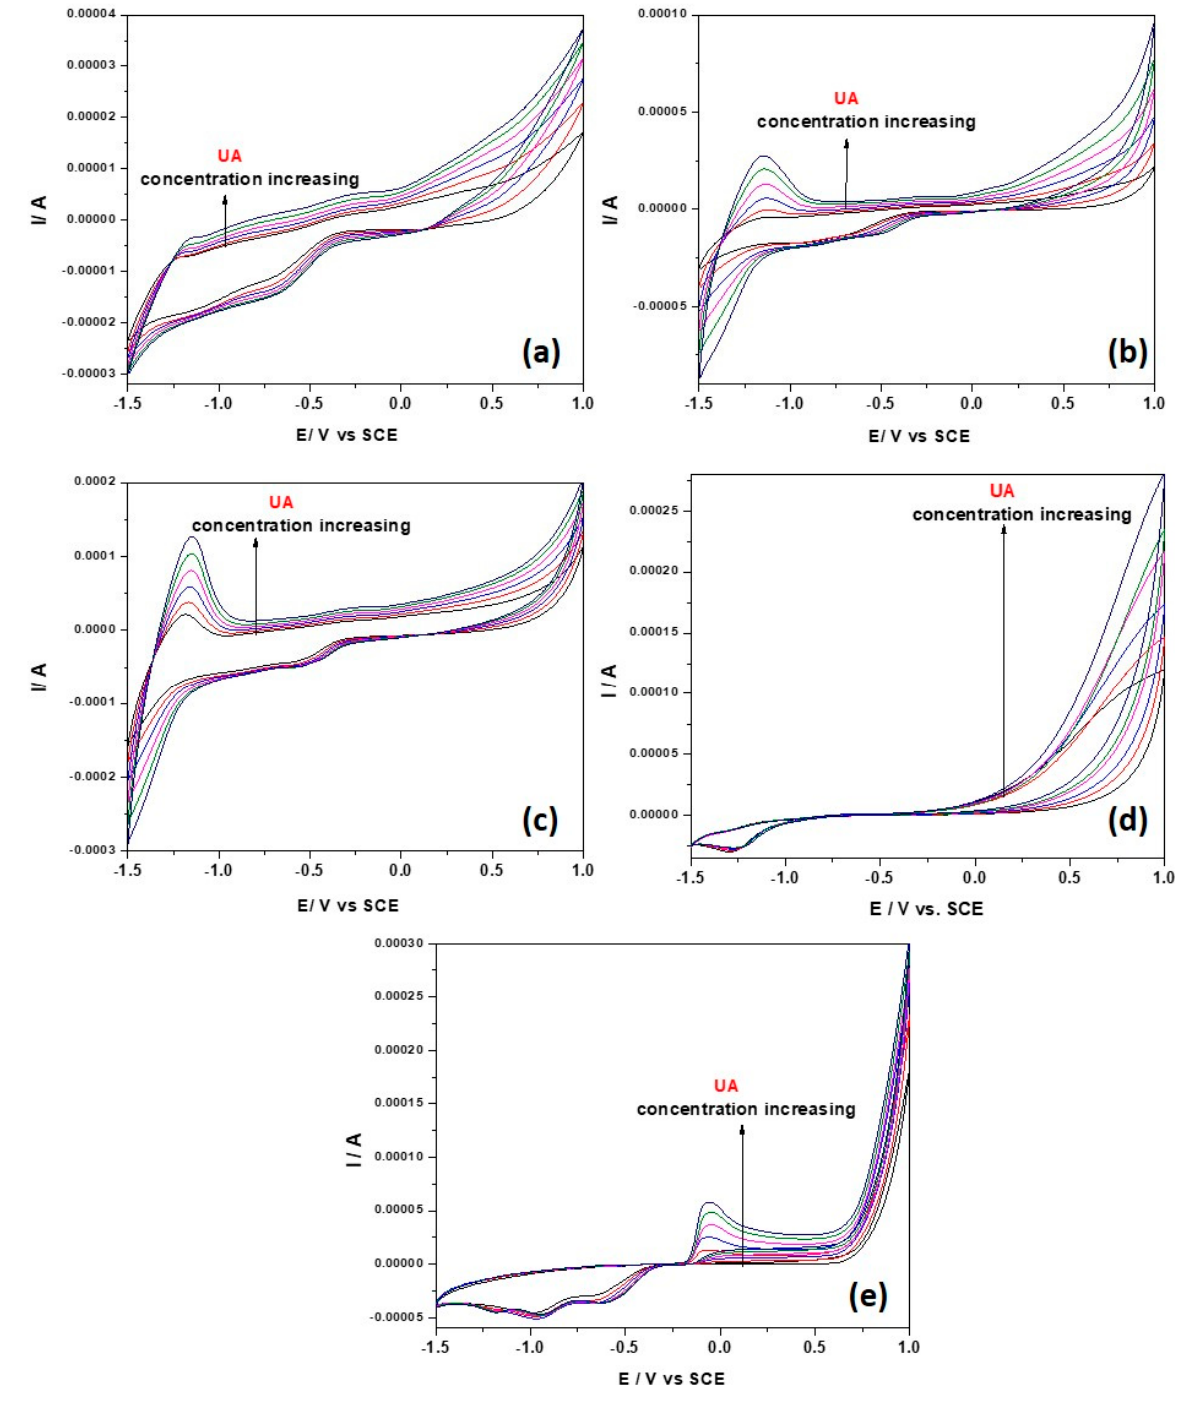
Figure 5. Cyclic voltammograms recorded with potential scan rate of 0.05 V · s − 1 within potential range from − 1.50 V to +1.00 V/SCE in 0.1 M NaOH supporting electrolyte (black line) and in the presence of 1–5 mM UA concentrations at the electrodes (colored lines): ( a ) PE_01, ( b ) PE_02, ( c ) PE_03, ( d ) commercial Zn electrode and ( e ) CNT paste electrode.